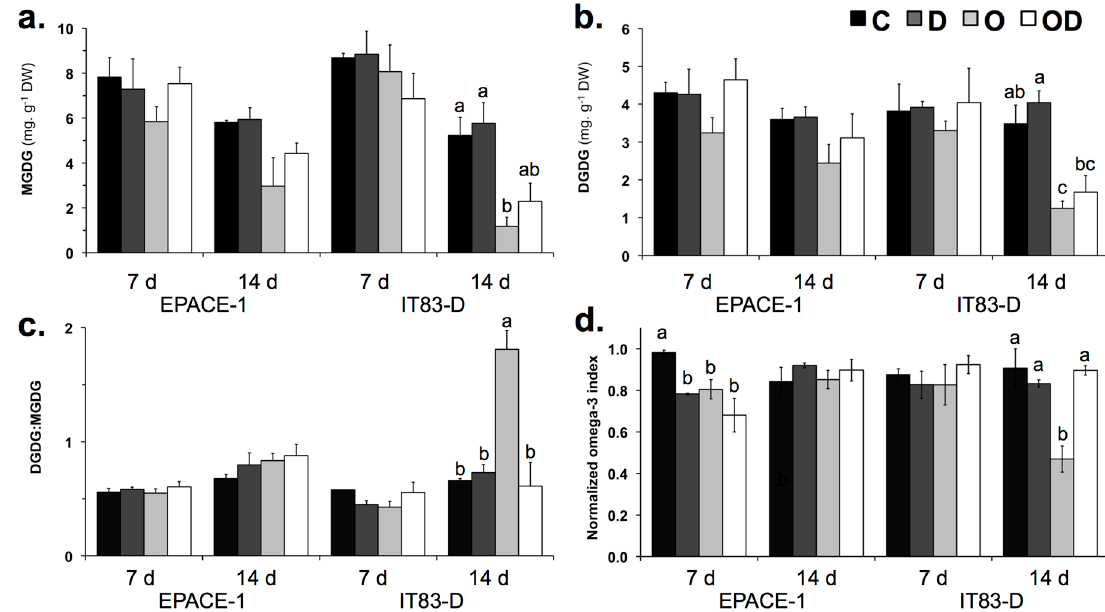
Figure 2. ( a ) MGDG contents; ( b ) DGDG contents; ( c ) DGDG:MGDG ratio and ( d ) normalized